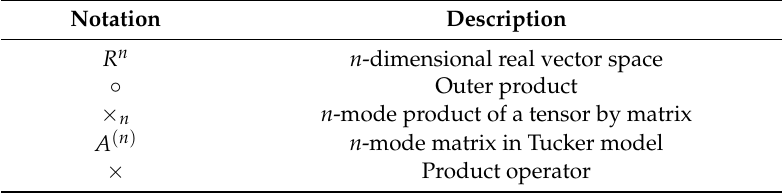
Table 2. Notations of NTD (nonnegative tensor decomposition).